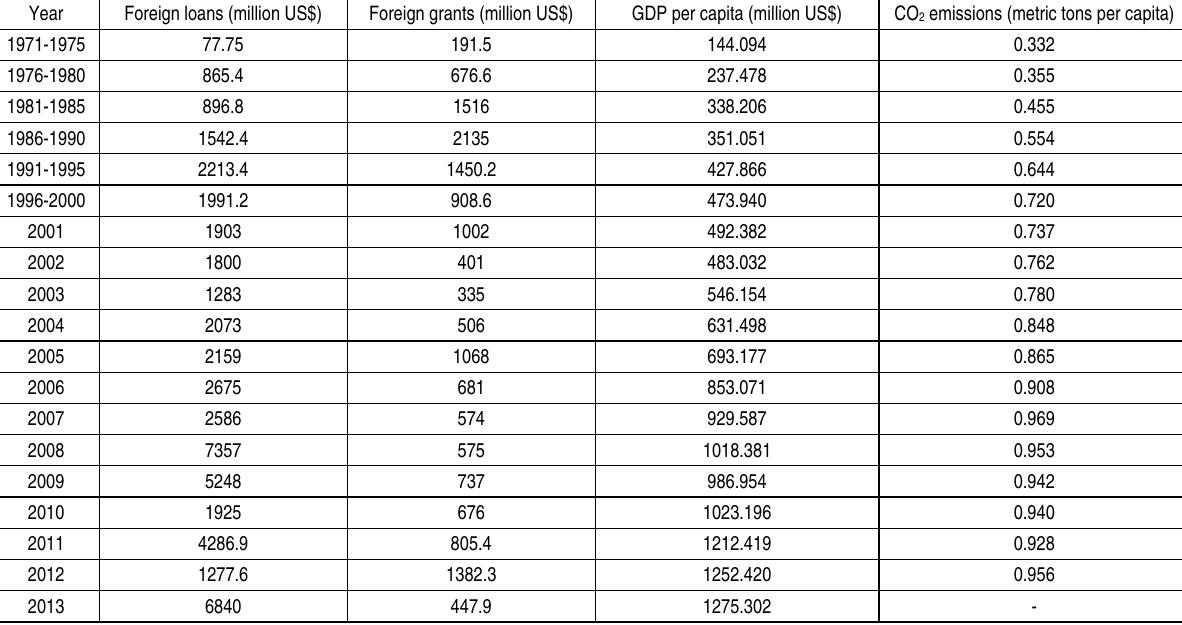
Source: Pakistan economic survey (various issues) and WDI’s, World